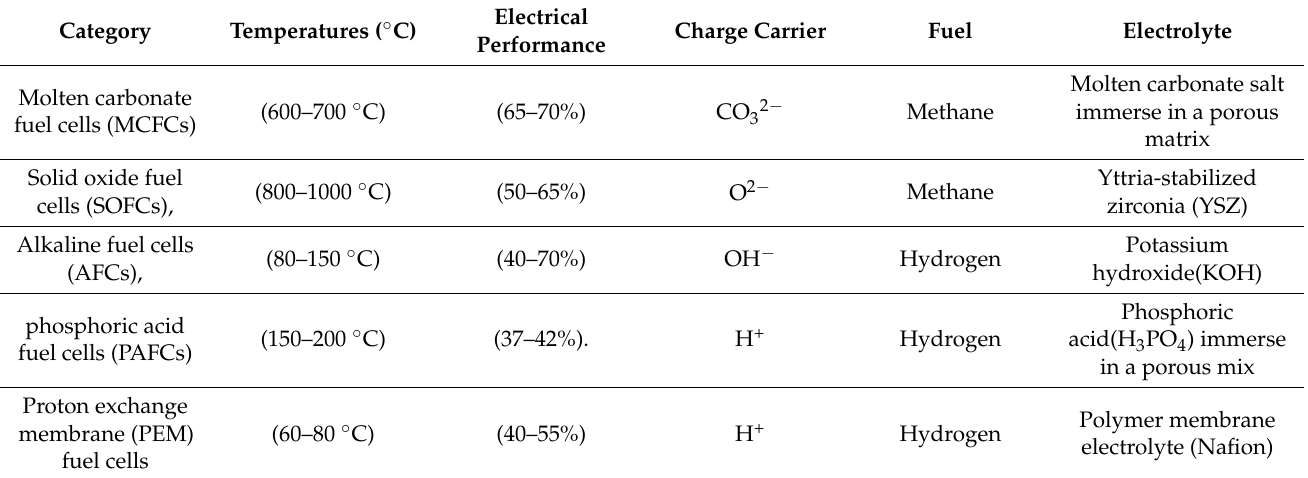
Table 1. Operating characteristics of fuel